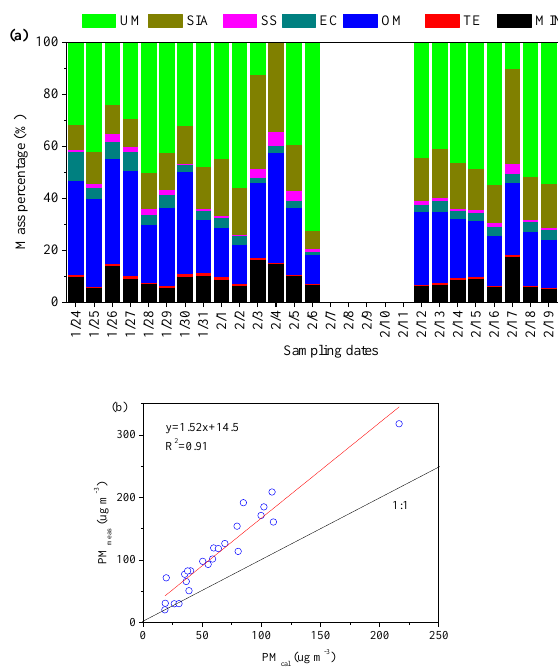
Figure 6. Mass balance of chemical species in PM 2 . 5 during sam- pling periods (a) and relationship between the mass calculated by adding individual components and the gravimetrically measured particulate mass (b) . MIN = 2 . 14 × Si + 1 . 67 × Ti + 1 . 89 × Al + 1 . 59 × Mn + 1 . 67 × Mg + 1 . 95 × Ca + 1 . 35 × Na + 1 . 21 × K + 1 . 43 ×